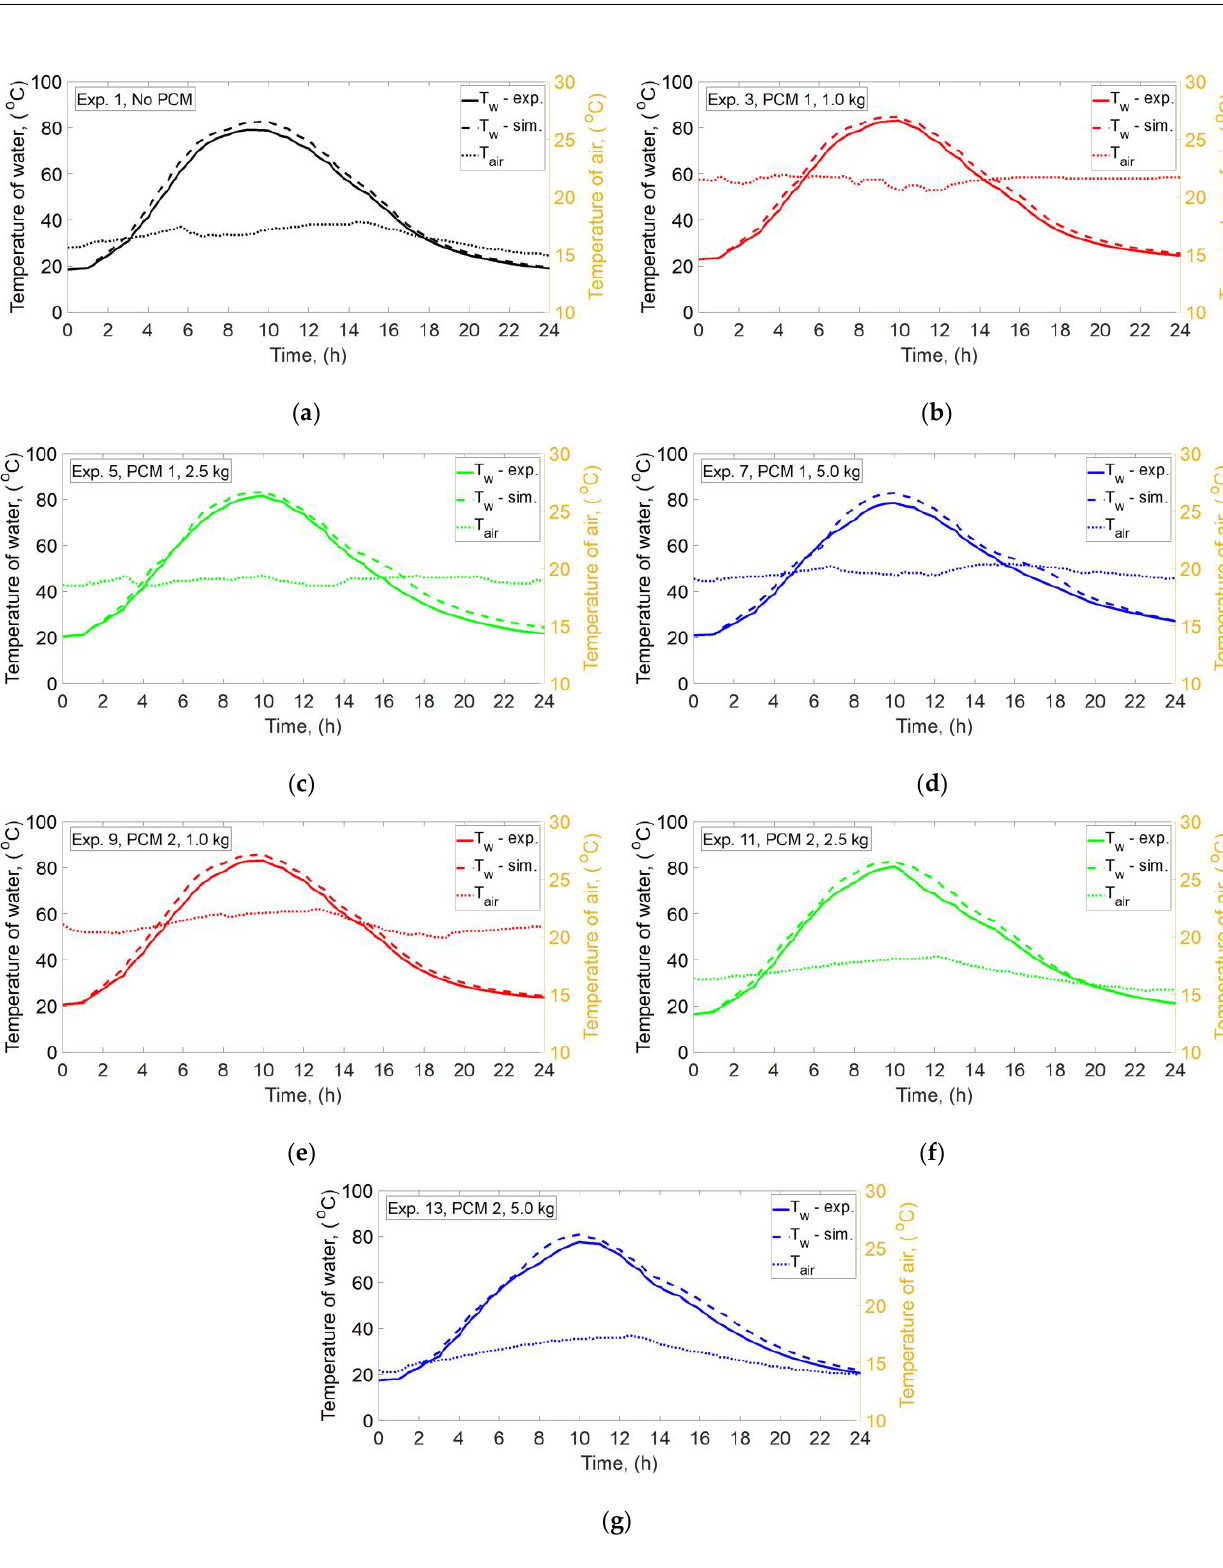
Figure 6. Temperature of ambient air (T air ) and temperature of water (T w ) for experiments (exp.) and simulations (sim.): ( a ) Experiment 1 (no PCM); ( b ) Experiment 3 (PCM 1, 1.0 kg); ( c ) Experiment 5 (PCM 1, 2.5 kg); ( d ) Experiment 7 (PCM 1, 5.0 kg); ( e ) Experiment 9 (PCM 2, 1.0 kg); ( f ) Experiment 11 (PCM 2, 2.5 kg); ( g ) Experiment 13 (PCM 2, 5.0 kg).